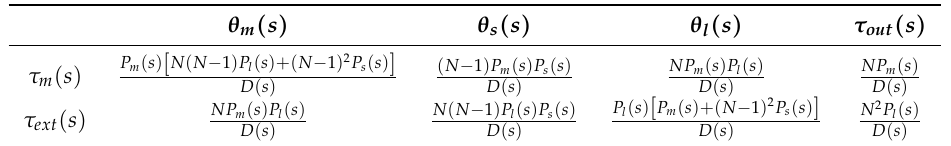
Figure 14. Dynamic modelling of cPEA. ( a ) free-body diagrams of cPEA and ( b ) block diagram representation of cPEA dynamics. Table 3. Transfer functions of